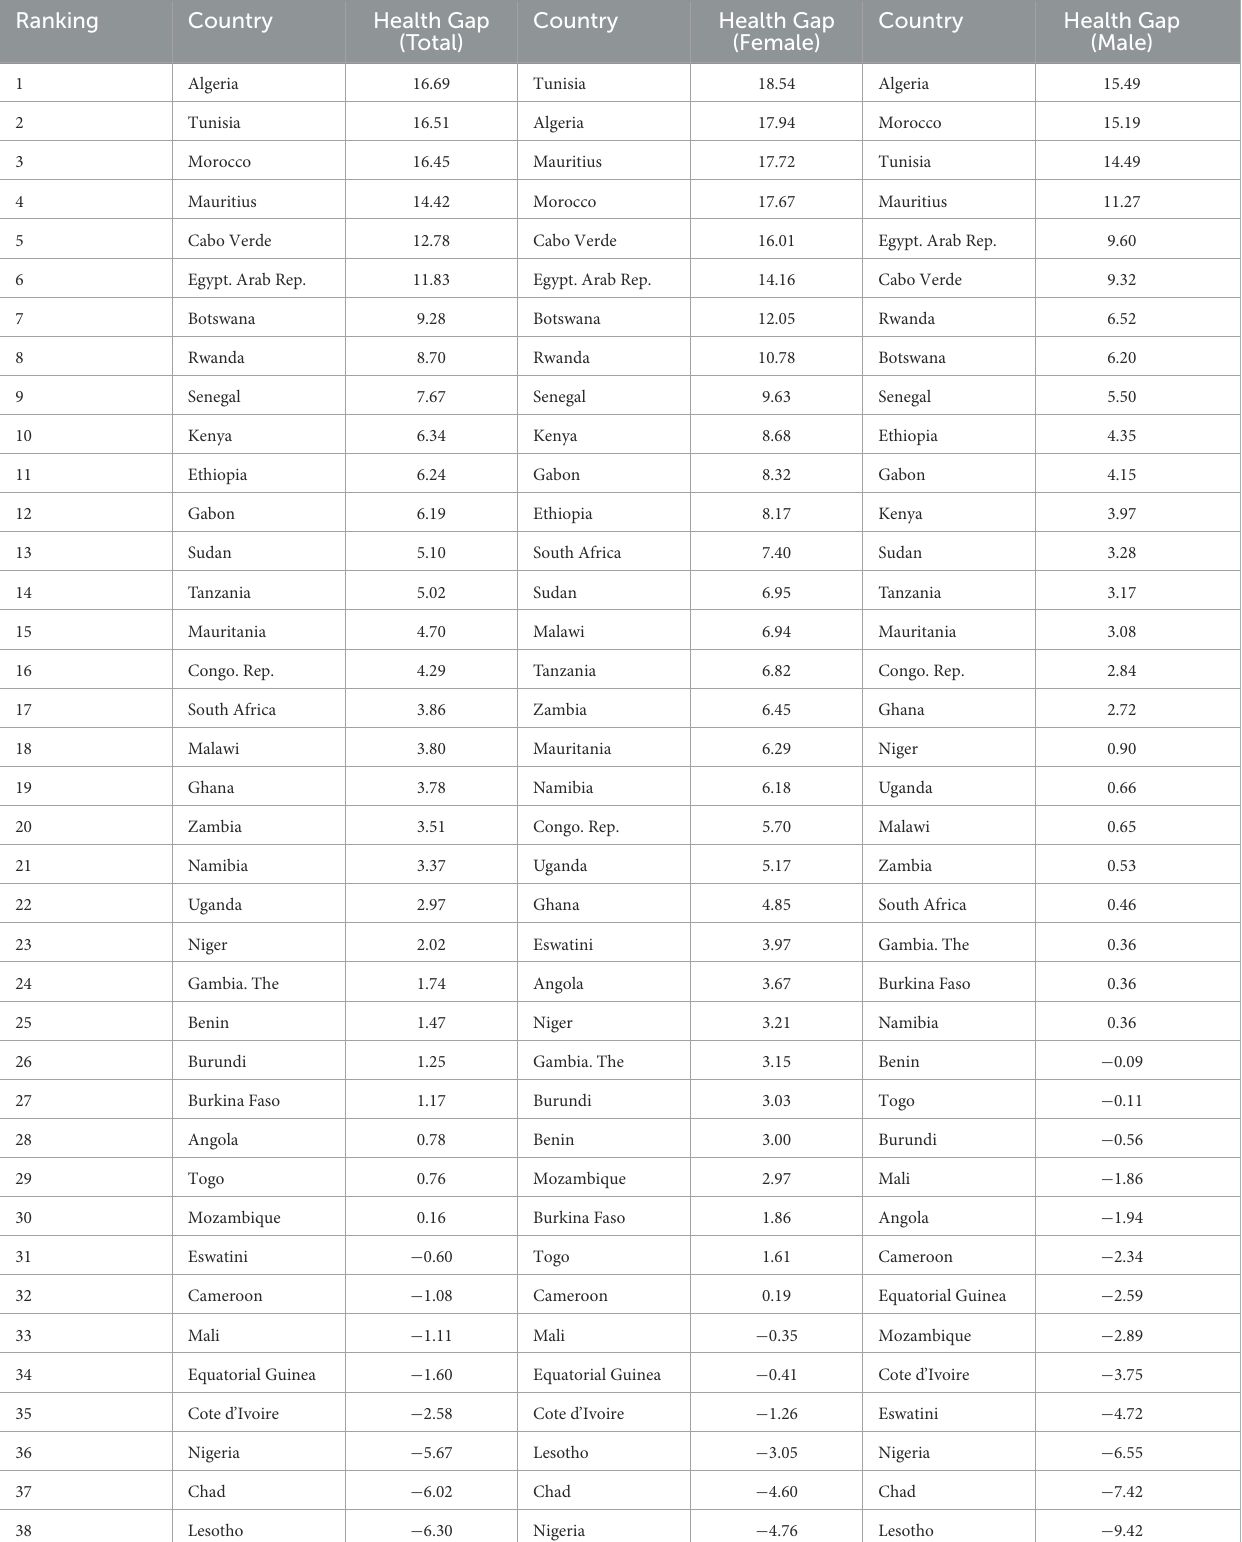
TABLE 2 2018 health gap ranking by total and gender.